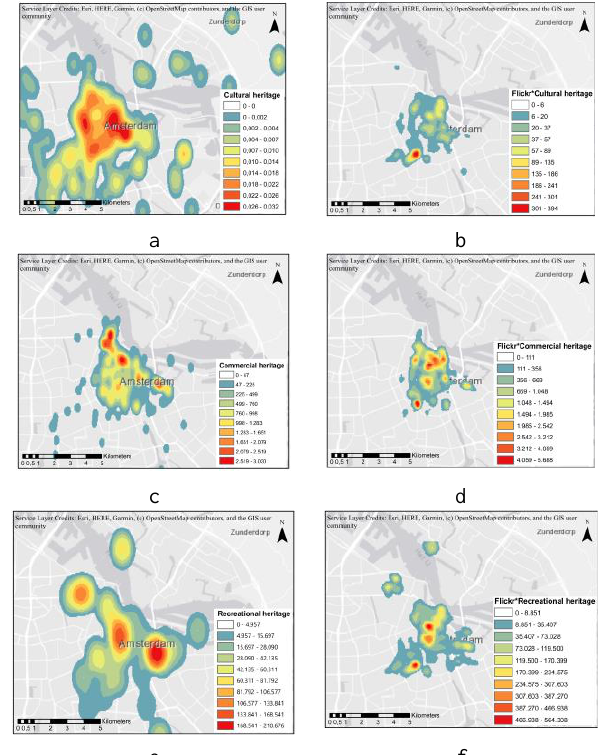
Figure 6. a . culture-education heritages b . tourists’